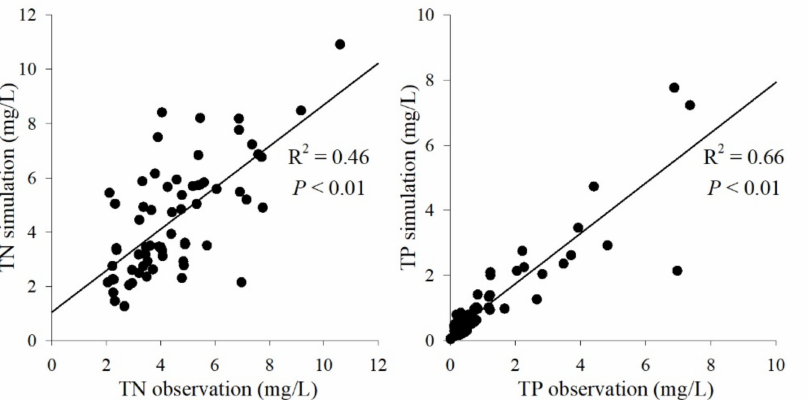
Figure 6. Relationship between the simulated concentration of total nitrogen (TN) and total phos- phorus (TP) by the Soil and Water Assessment Tool (SWAT) and the observed values in the Hun-Taizi River watershed.